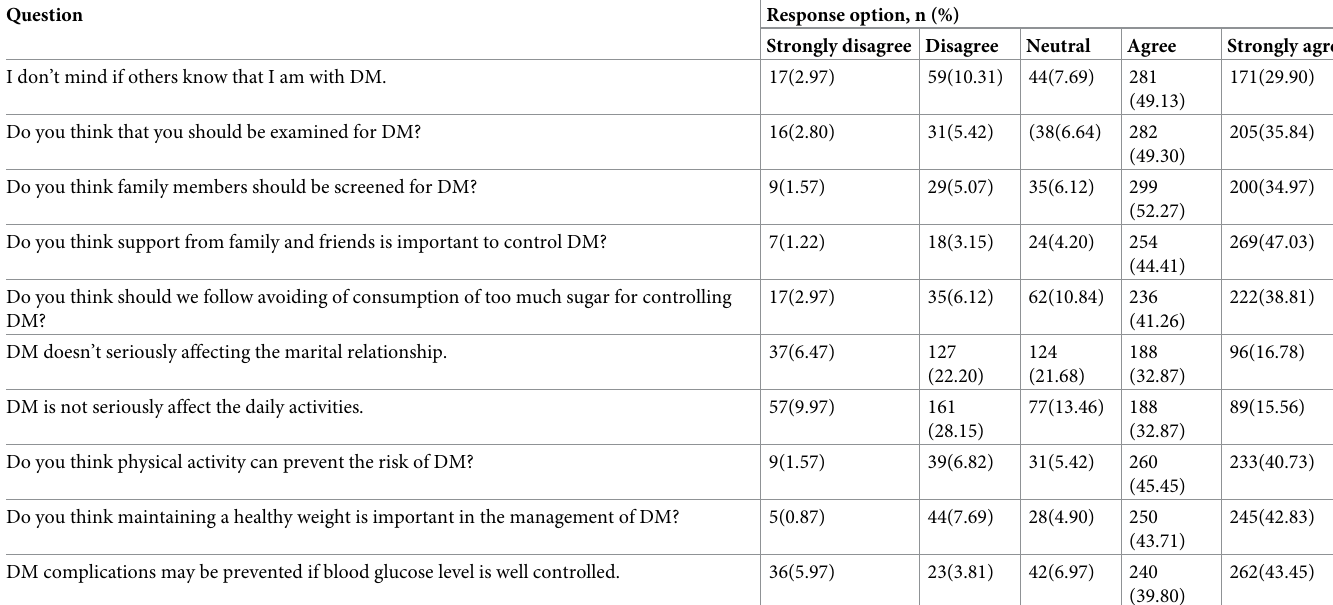
Table 2. Frequency distributions of respondents attitude towards diabetes mellitus among adult non-diabetes community members of Gondar city, Ethiopia 2019 (n = 572). Question Response option, n (%)